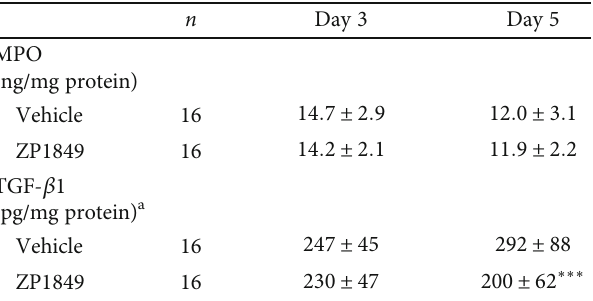
Table 2: MPO and TGF- β 1 proteins in colonic anastomotic wounds on days 3 and 5.